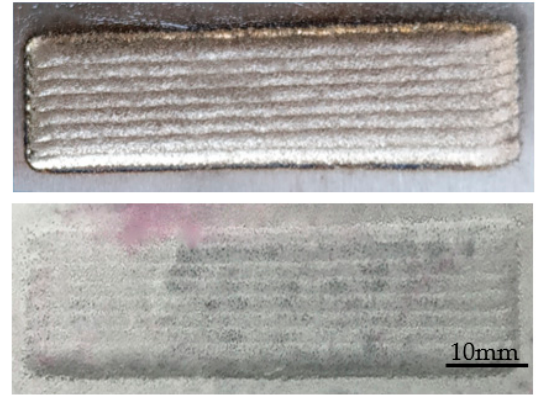
Figure 10. Validation results of the optimized parameters.